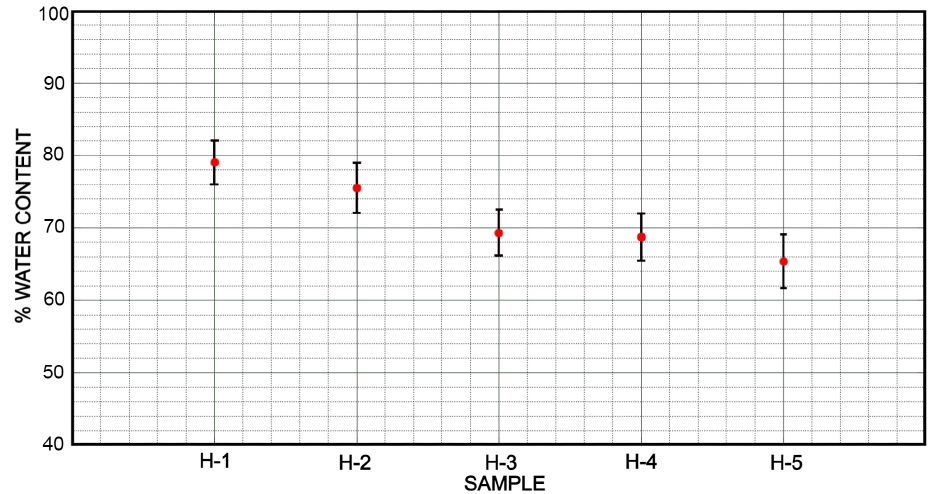
Figure 10. The weight of water content that can be retained by the five hydrogel samples exceeds 60%, however, only the H-1 sample was able to be placed very close to 80% water retention. This water retention also provides them with greater flexibility.